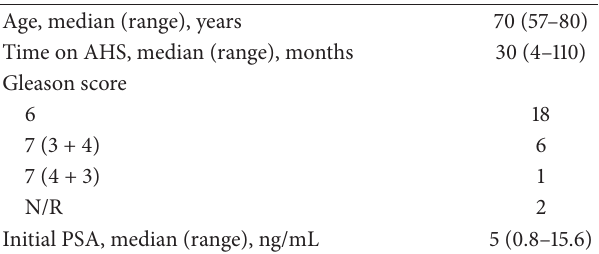
Table 4: Demographics of patients who discontinued AHS ( 𝑁 = 27 ).